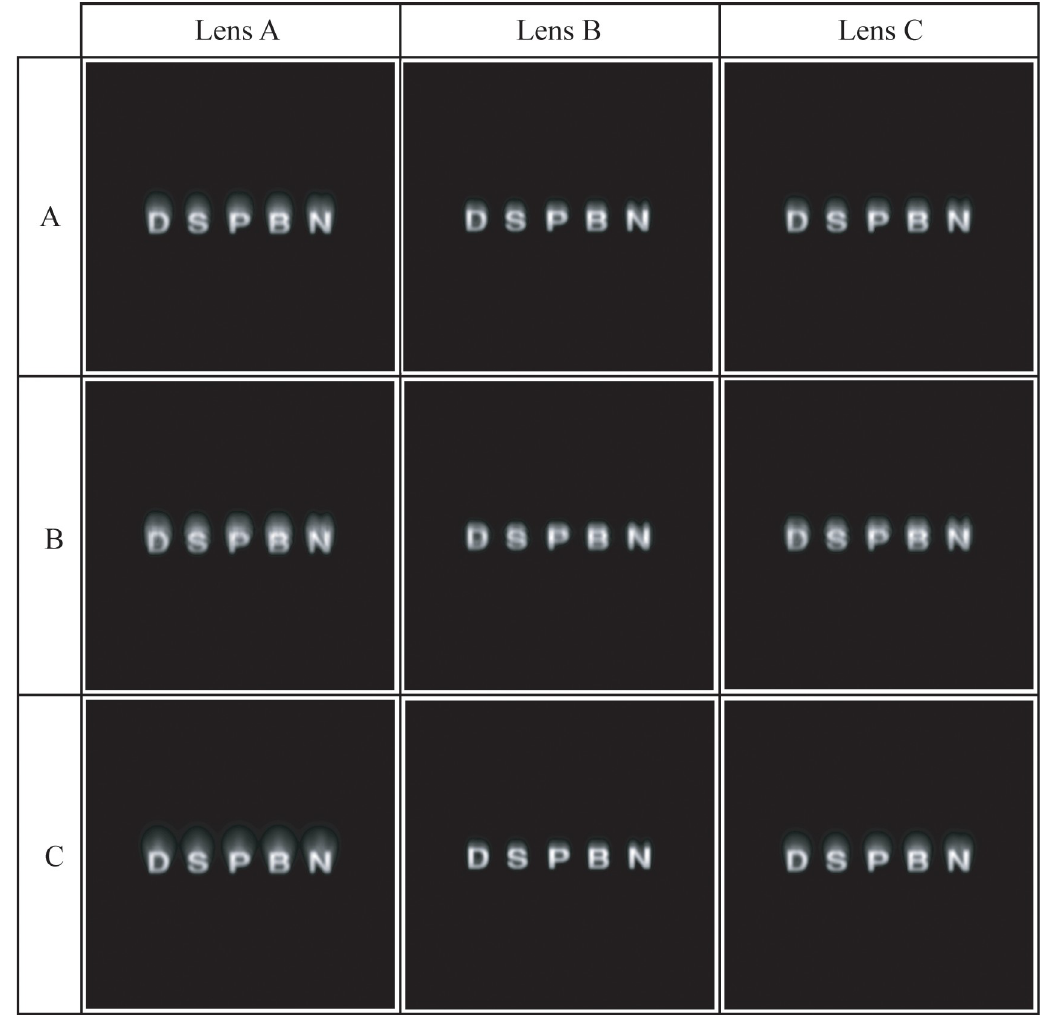
Fig 7. Simulation of the retinal images of a 5’ angular size optotype (VA of 0.00 LogMar scale) generated by each designed IOL (in columns: Lens A, Lens B and Lens C) with every cornea (in rows: A) Normal, B) Myopic, C) Hyperopic) at the worst-case scenario (a combination of 5 degrees of tilt and 1 mm misalignment of the